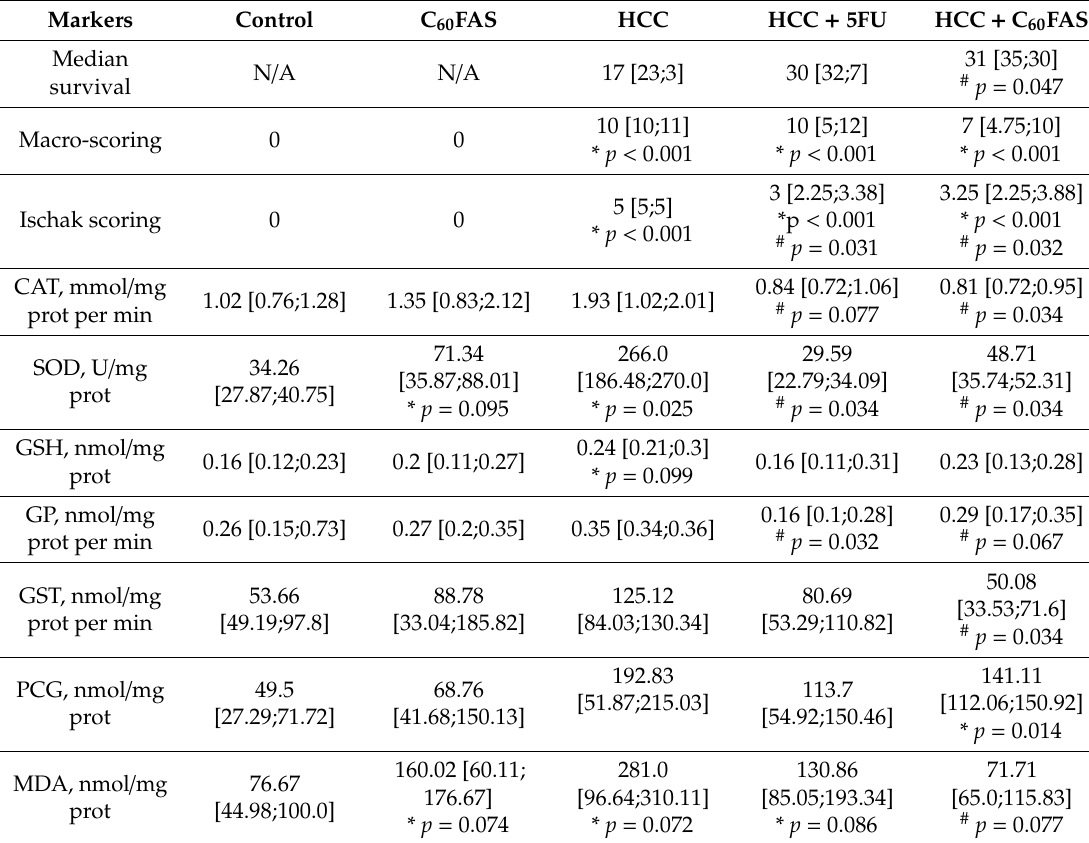
Table 3. Median survival, liver injury and redox state markers of HCC-rats treated by 5FU and C 60 FAS (50 [25;75]